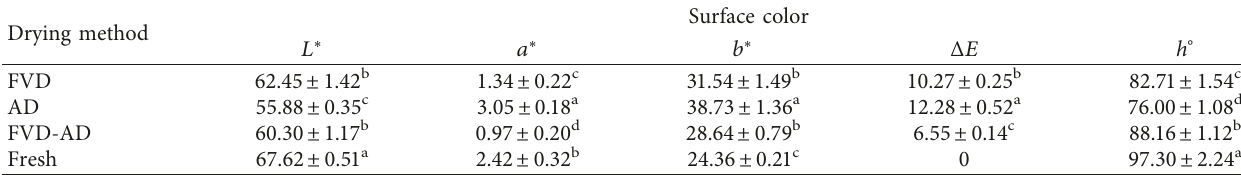
Figure 1: Flow diagram of kiwifruit samples preparation and testing. Table 1: Color parameters of kiwifruits samples dried by different drying